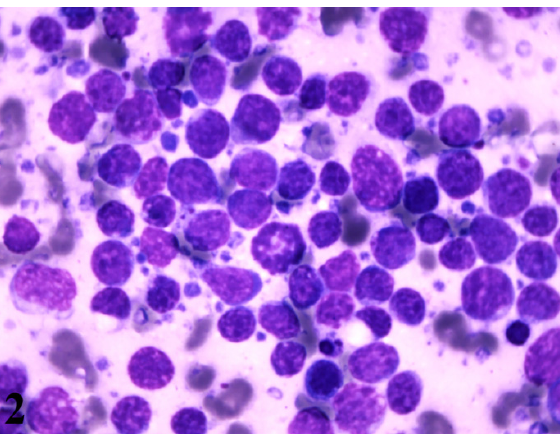
Figure 2. Photomicrograph of fine needle aspirate obtained from a renal mass. The majority of the cell population is composed of large lymphocytes. The background is eosinophilic and small round basophilic structures are noted (lymphoglandular bodies). The morphological appearance is diagnostic of large cell lymphoma. Renal epithelial cells are not observed. Wright Giemsa stain, oil 1000×.